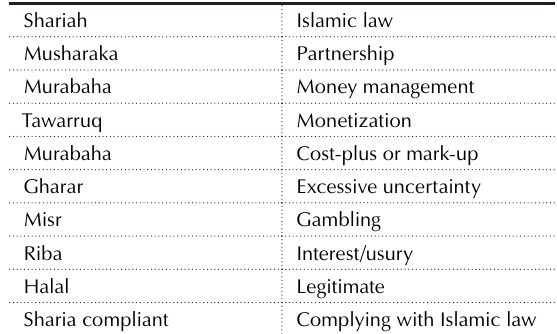
Table 1. Arabic terms used in this